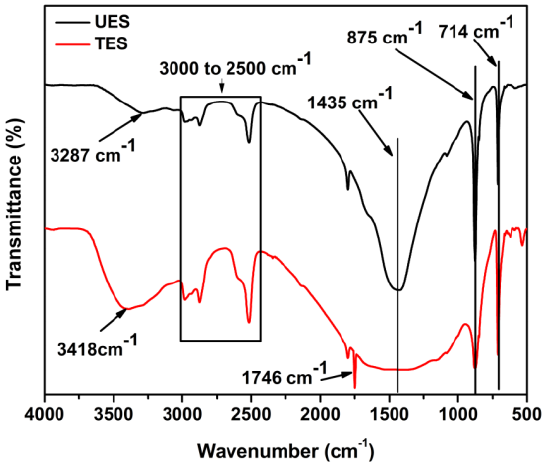
Figure 1. FTIR spectra of UES and TES particles.